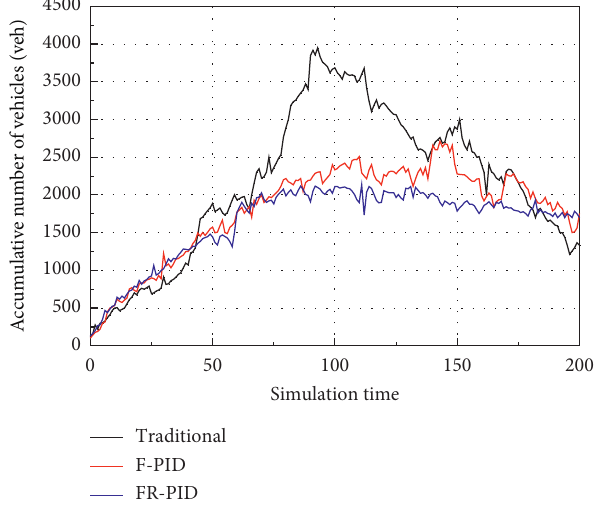
Figure 10: Accumulative number of vehicles. Table 1: Boundary control target range.